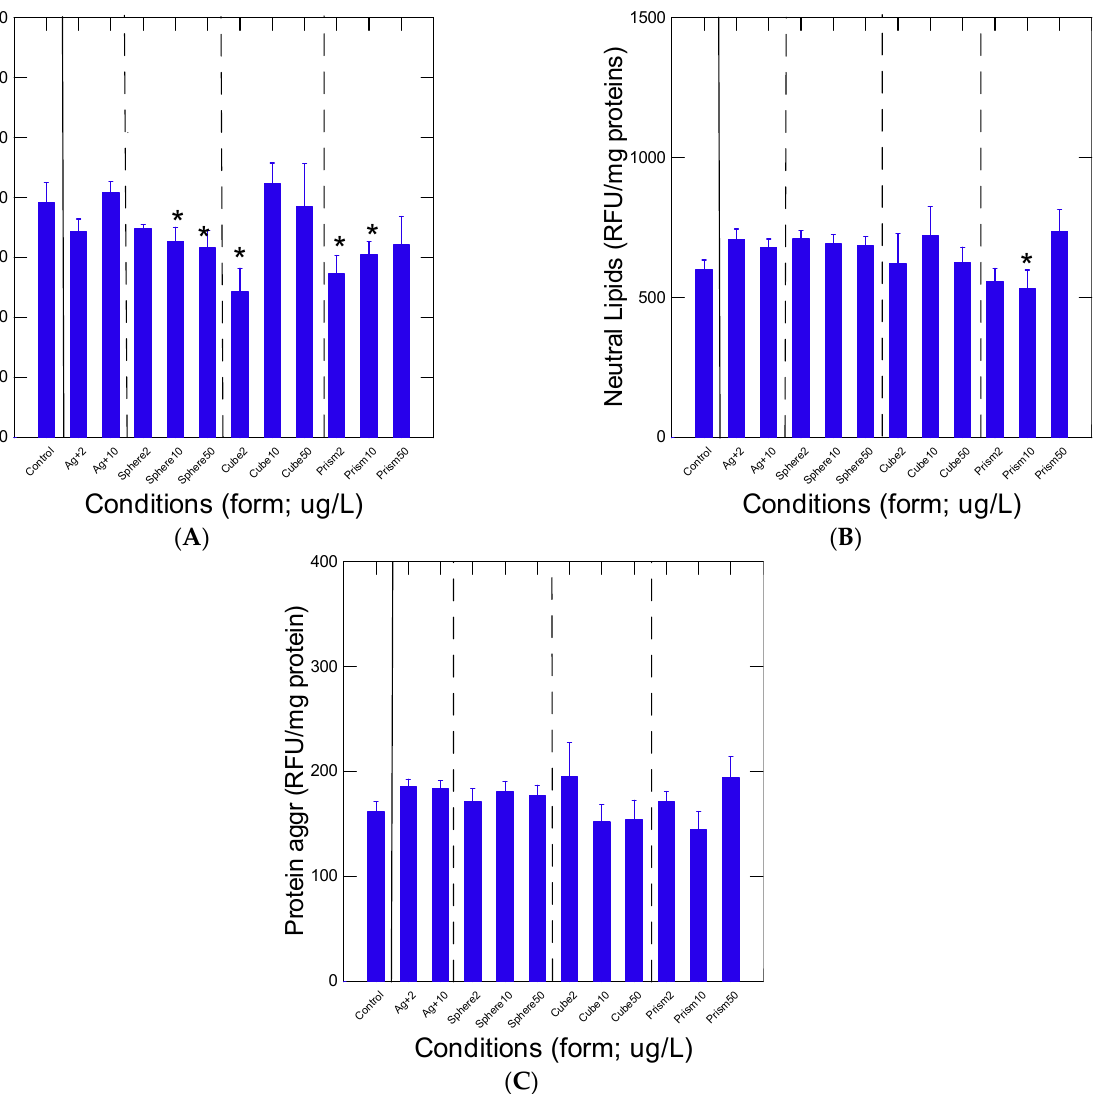
Figure 2. Changes in cytoplasm properties in mussels exposed to nAg forms. Mussel whole tissue homogenate fractions were isolated and analyzed for viscosity ( A ), protein aggregation changes ( B ) and neutral lipids ( C ). The data represent the mean with the standard error. The star symbol * indicates significant differences from